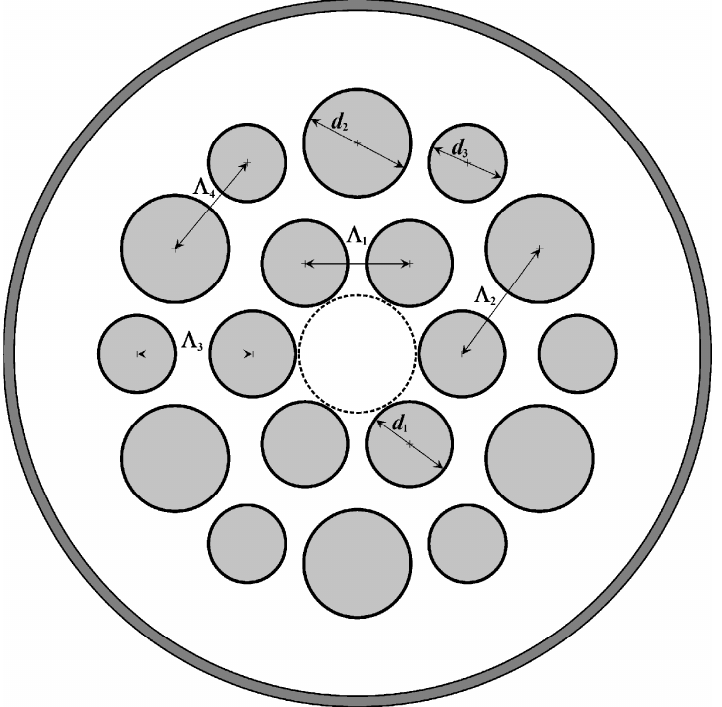
Figure 1. Structure of MOF-18: d 1 / Λ 1 = 0.82; d 2 / d 1 = 1.25; d 3 / d 1 = 0.90; Λ 2 / Λ 1 = 1.25; Λ 3 / Λ 1 = 1.10.